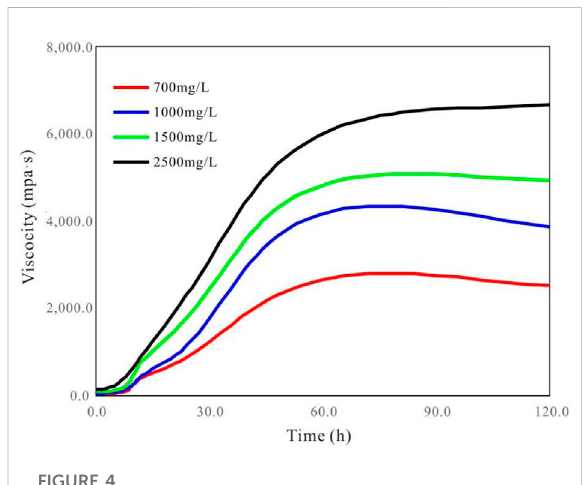
FIGURE 4 Variation of viscosity of polymer gel pro fi le control agent system with time.